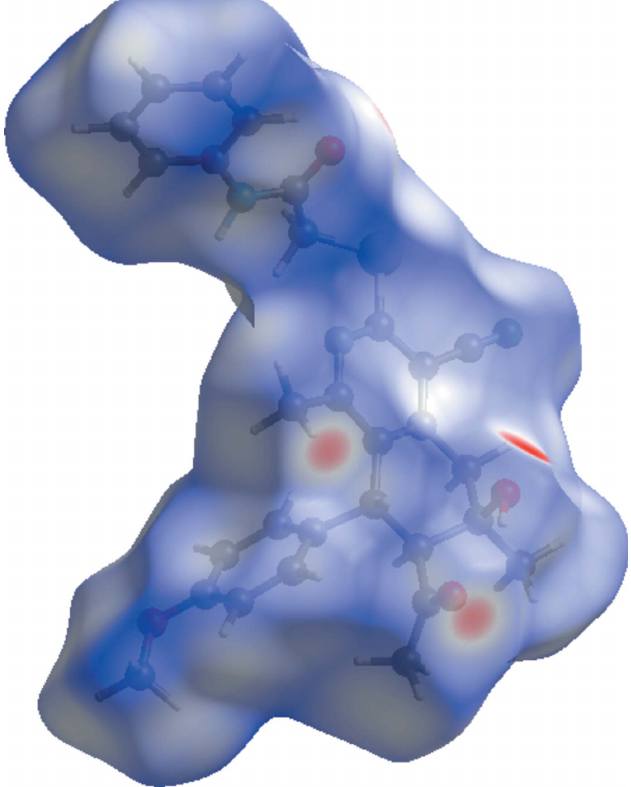
Figure 4 A view of the three-dimensional Hirshfeld surface of the title molecule plotted over d norm in the range (cid:3) 0.5236 to +1.6751 a.u.